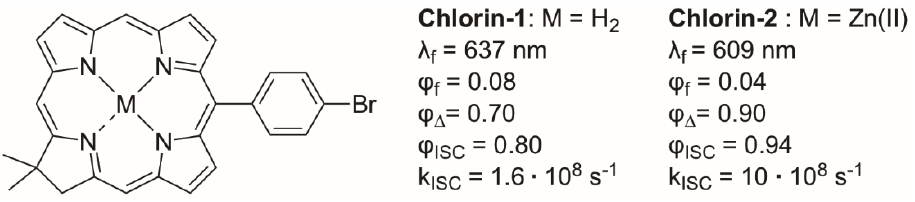
Figure 6. Zn(II) coordinated gem -dimethyl chlorin ( Chlorin-2 ) and its free base counterpart ( Chlorin-1 ). Experimental results shown in ethanol [63].